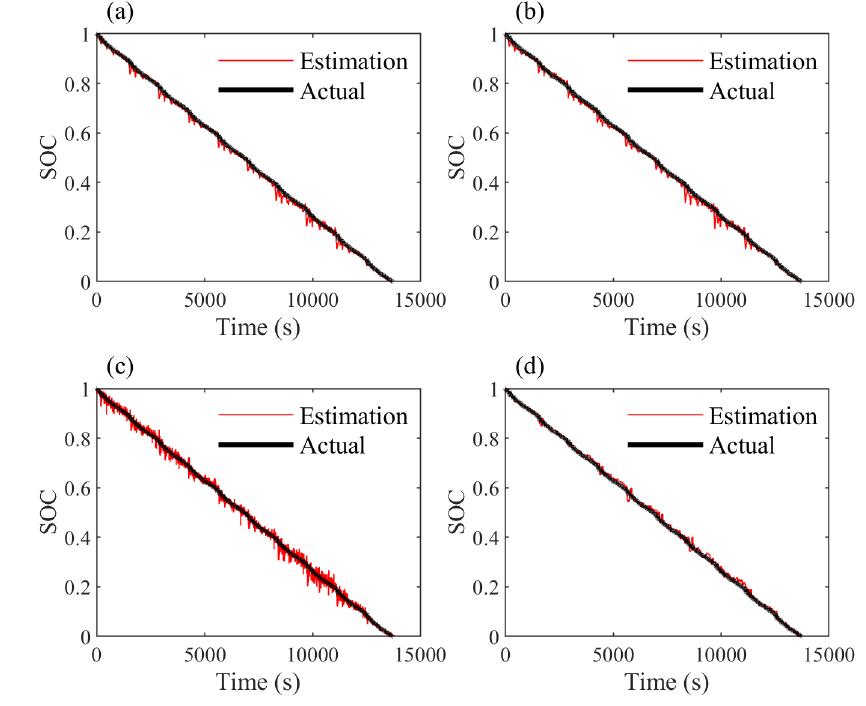
Figure 17. SOC estimation results for the UDDS profile with different pre-process methods: ( a ) aver-